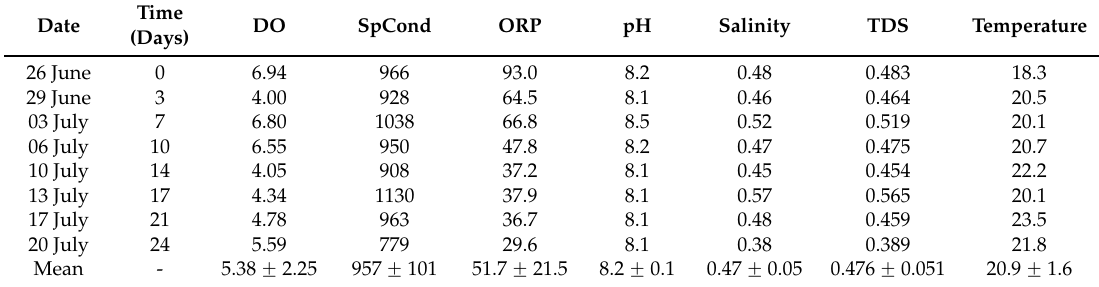
Table 2. Water quality parameters in Millersville, PA of dissolved oxygen (mg/L), pH, specific conductivity ( µ S/cm), water temperature ( ˝ C), total dissolved solids (g/L), oxidation reduction potential (mV), and salinity (ppt) were measured at a single location 30 m upstream of the uppermost carcass and 30 m downstream of the lowermost carcass on each sampling day using a Horiba ® (Kyoto, Japan) Multi Water Quality Checker (U-50 Series).